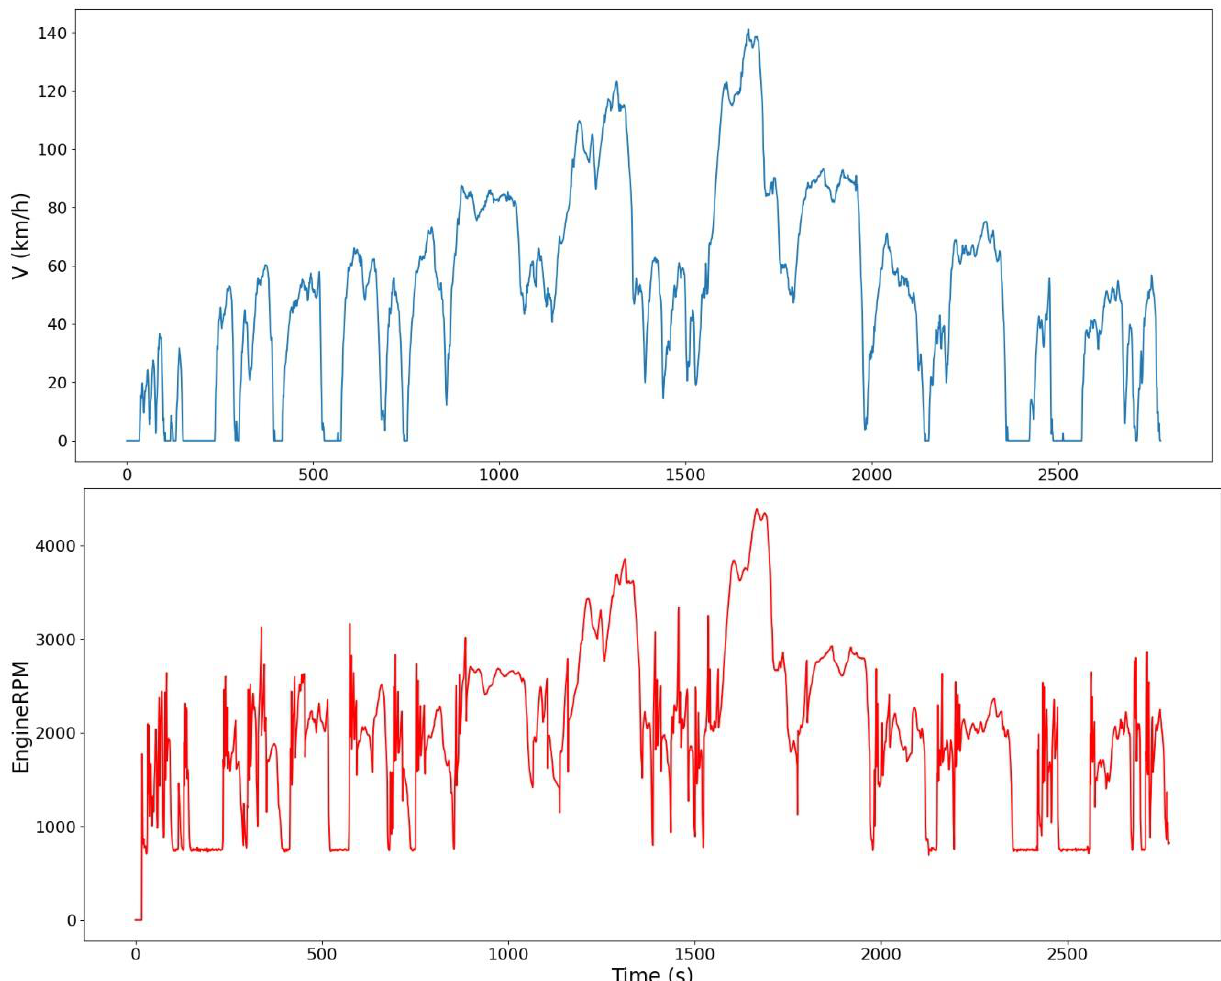
Figure 6. Velocity and engine RPM obtained during road test for the LPG-fuelled vehicle.